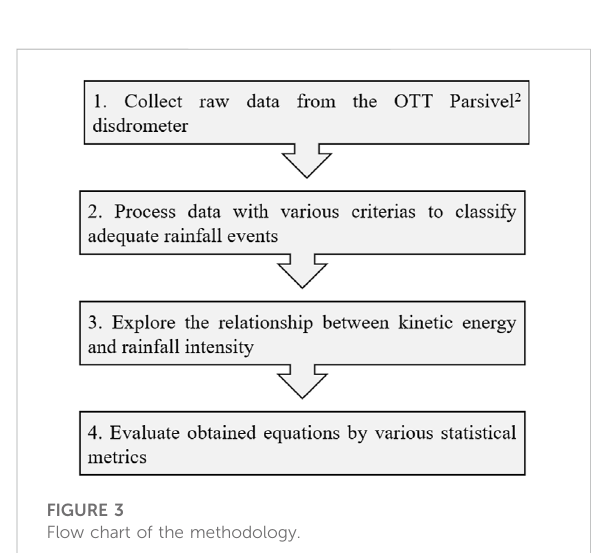
FIGURE 3 Flow chart of the